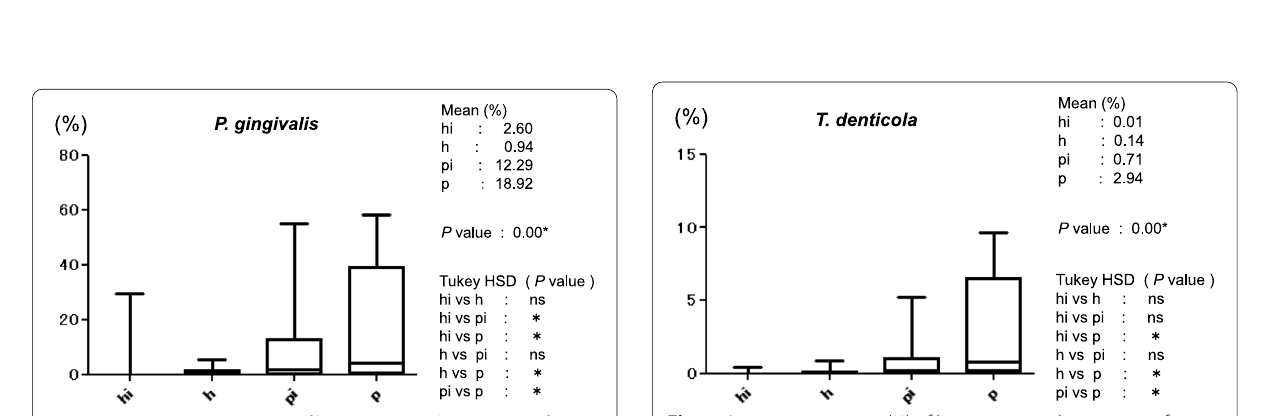
Fig. 5 Average proportion (%) of bacteria to total copy-count for Porphyromonas gingivalis